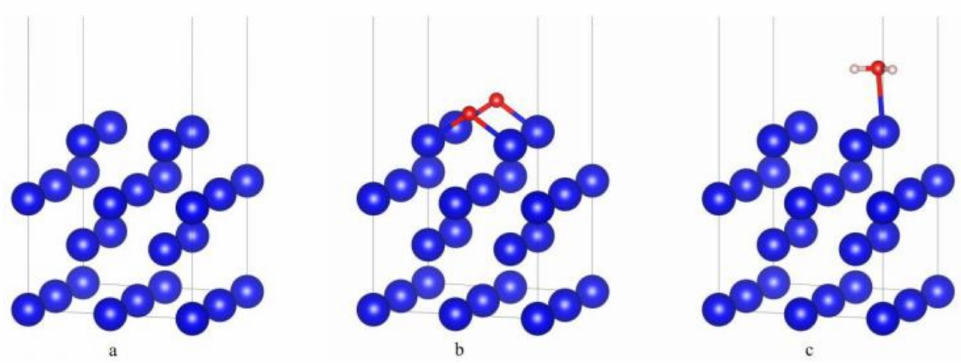
Figure 1. ( a ) The surface structure of four layers δ -Pu (100). ( b ) The most stable adsorption configuration of O 2 single adsorption. ( c ) The most stable adsorption configuration of H 2 O single